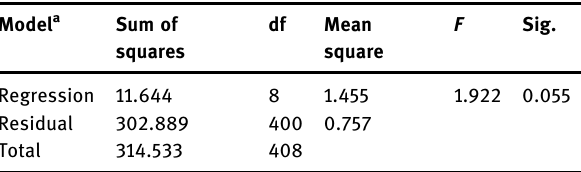
Table 15: ANOVA for model two ( dependent variable: healthy diet behavior and attitude ) Model a